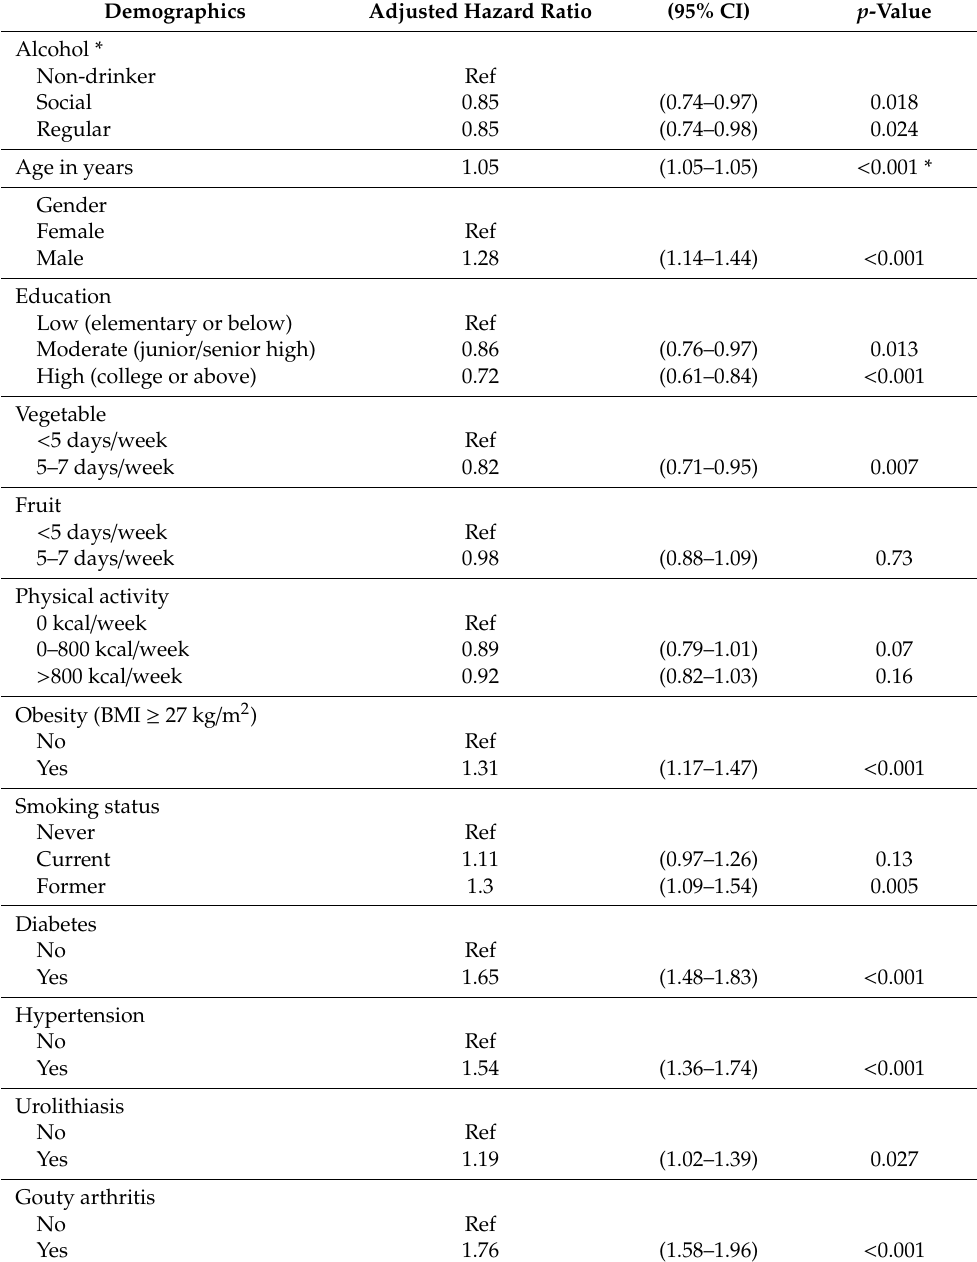
Table 2. Results of the multivariable Cox proportional hazards analysis of the incidence of chronic kidney